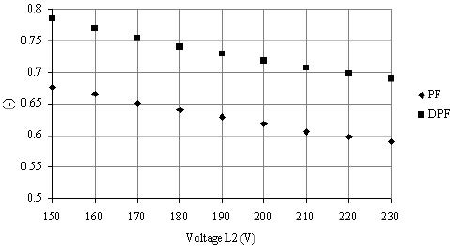
Figure 11. The average value PF and the average value DPF at the three phases depending on the supply voltage at phase b (set 2).